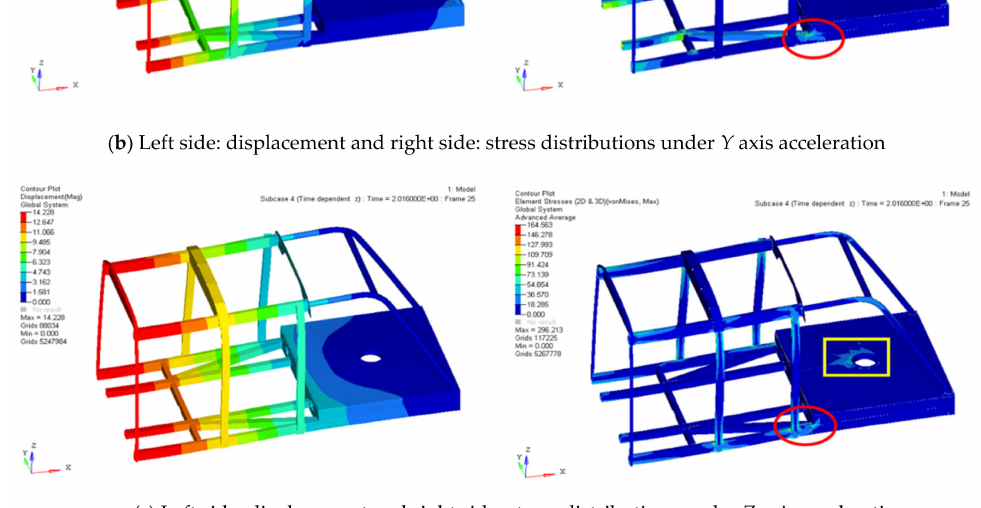
Figure 6. Left side: displacement and right side: stress distributions of the half chassis model under ( a ) X -axis (Scale factor = 100), ( b ) Y -axis (Scale factor = 100) and ( c ) Z -axis (Scale factor = 50) accelerations at 2.016 s; red and yellow box circles the high stress regions at lower chassis connection and bogie mount,